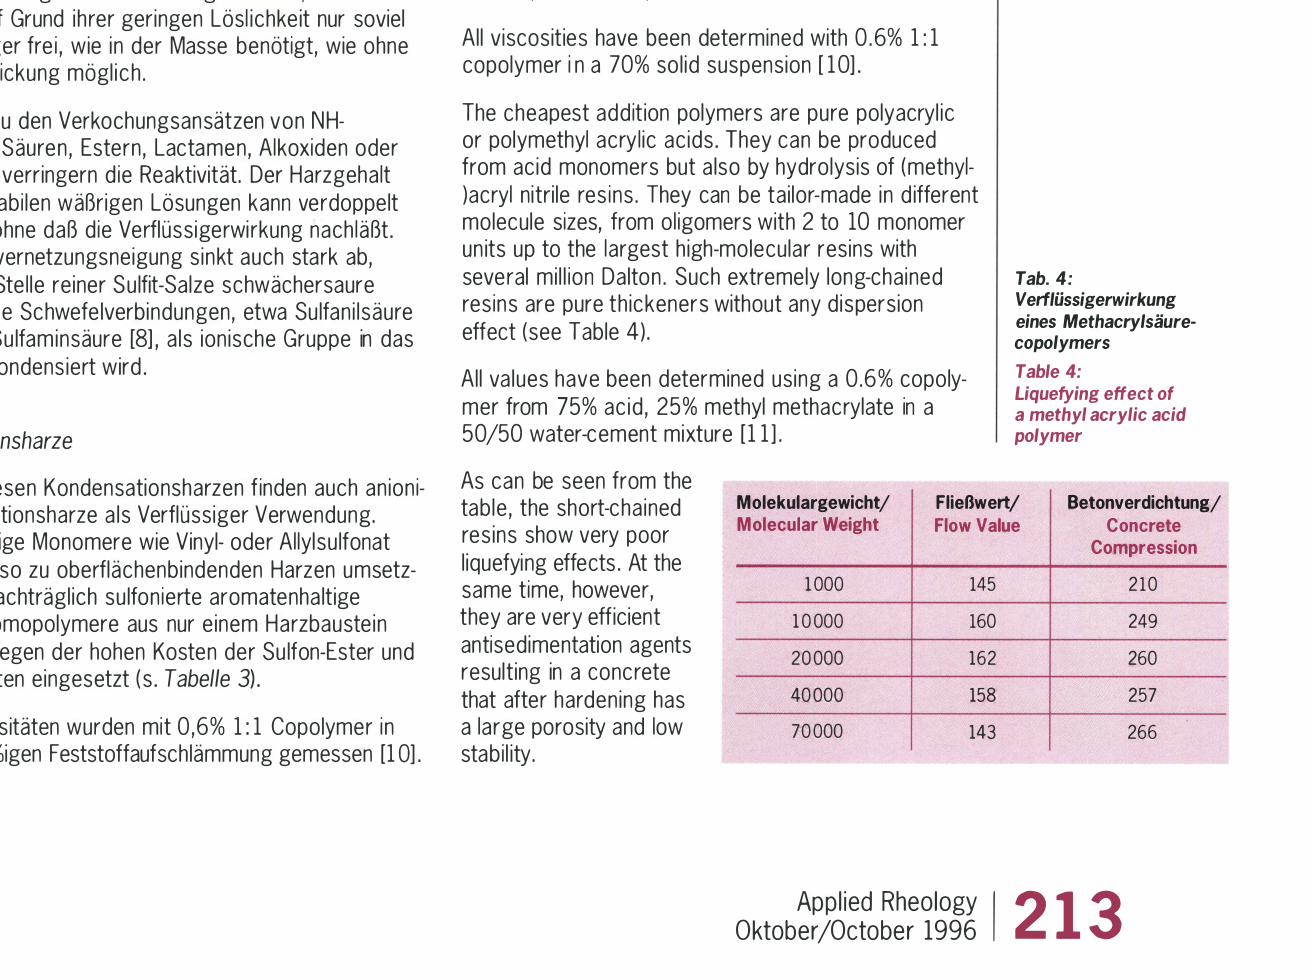
eines Methacrylsiiure­ copolymers Table 4: Liquefying effect